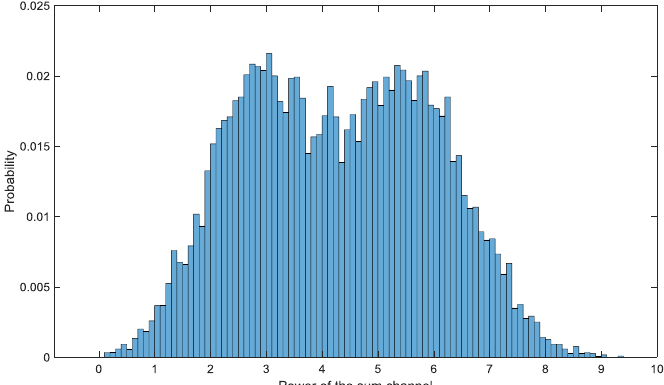
Figure 4. Normalized histogram of the sum channel power of a sample which samples echoes of only one scattering center. The echo of the scattering center is generated by a bimodal distribution composed of two Gaussian components. The parameters set for Gaussian component 1 is µ 1 = 3.954, σ 1 = 0.3954 and the parameter set for component 2 is µ 2 = 7.908, σ 2 = 0.3954 .